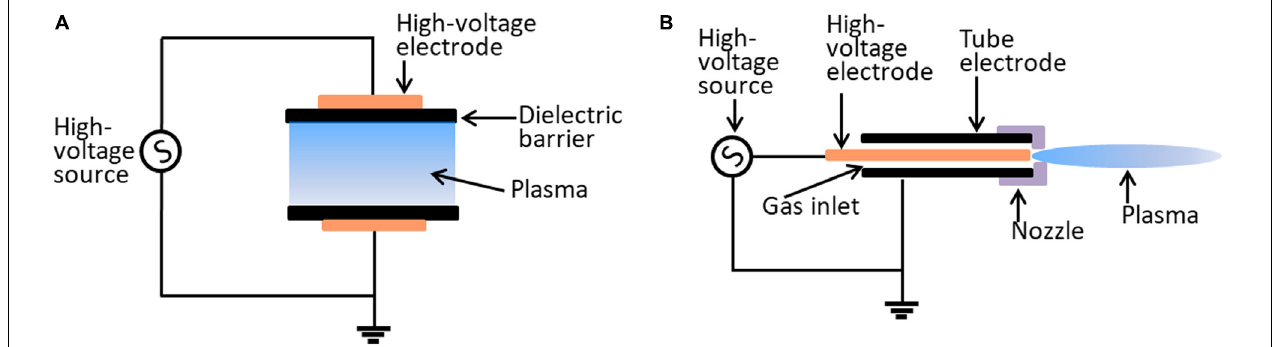
FIGURE 1 | Schematic diagram of the typical configurations of CAP device. (A) The dielectric barrier discharge system. (B) The atmospheric plasma jet system.